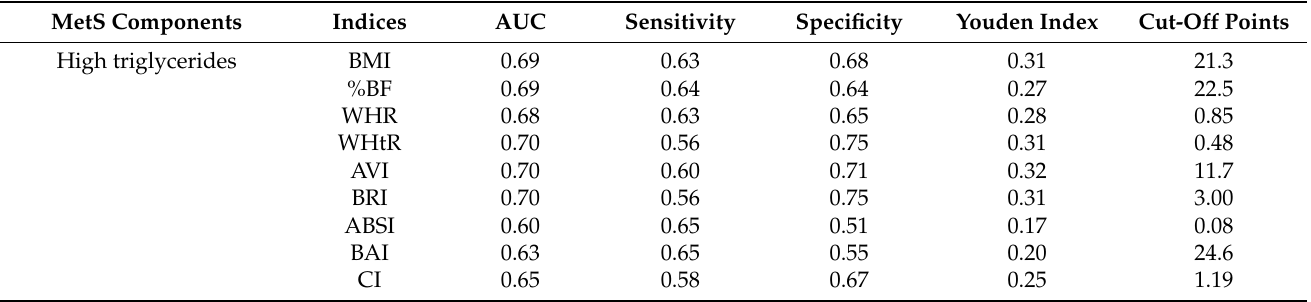
Table 3. Areas under the curve (AUCs) and cut-off points for anthropometric indices for the prediction of MetS components in